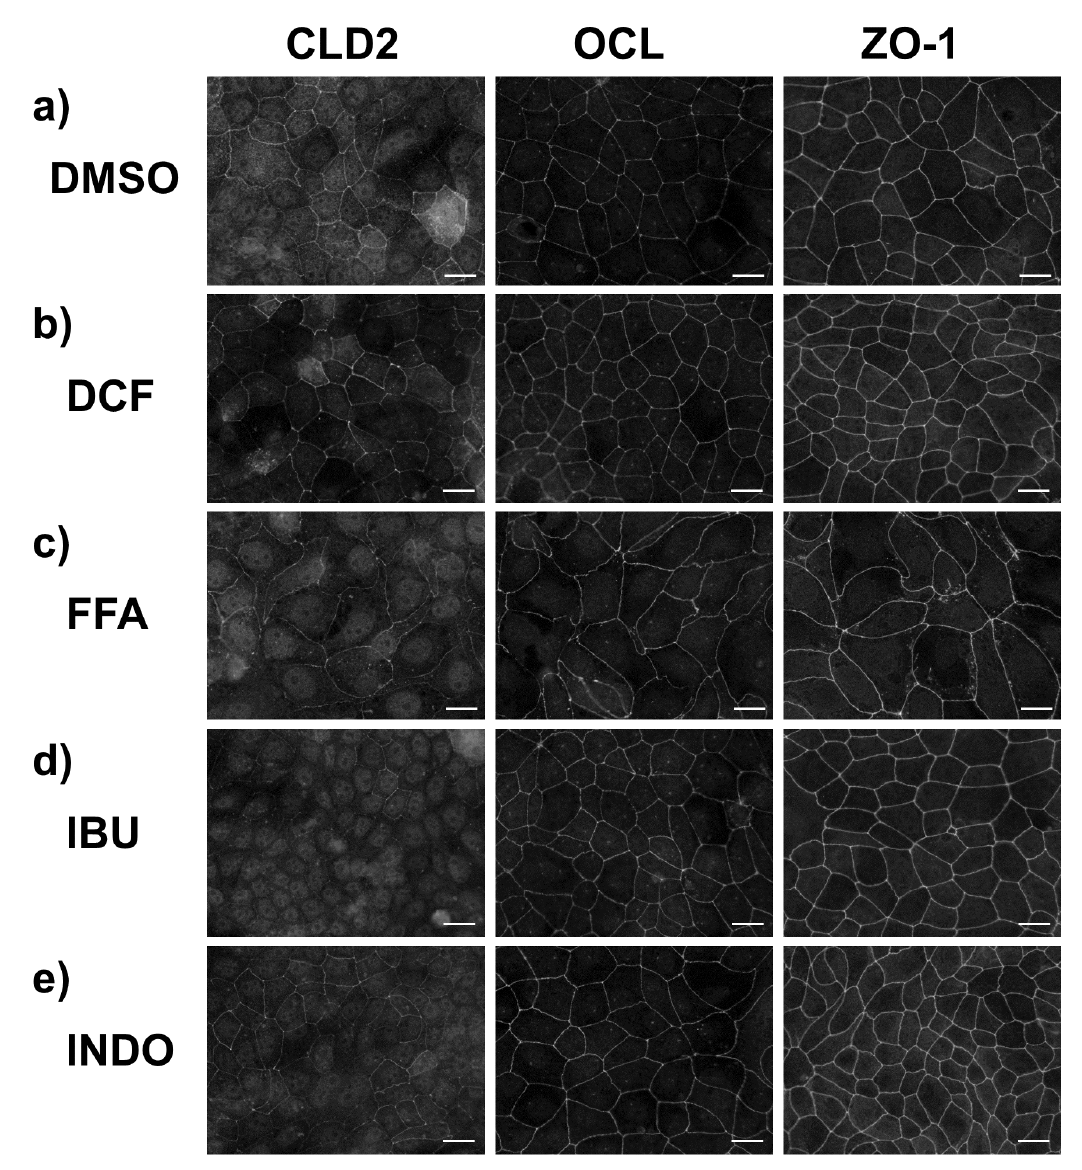
Figure 5. Effects of NSAIDs on tight junction integrity of MDCK II cells. Immunofluorescence staining of claudin-2 (CLD-2, left), occludin (OCL, middle), and ZO-1 (right) images are arrayed. Cells were treated with NSAIDs at a concentration of 100 µM for 48 h. ( a ) control (DMSO), ( b ) DCF, ( c ) FFA, ( d ) IBU, and ( e ) INDO. Scale bar = 20 µM. Brightness is modified to 160%.